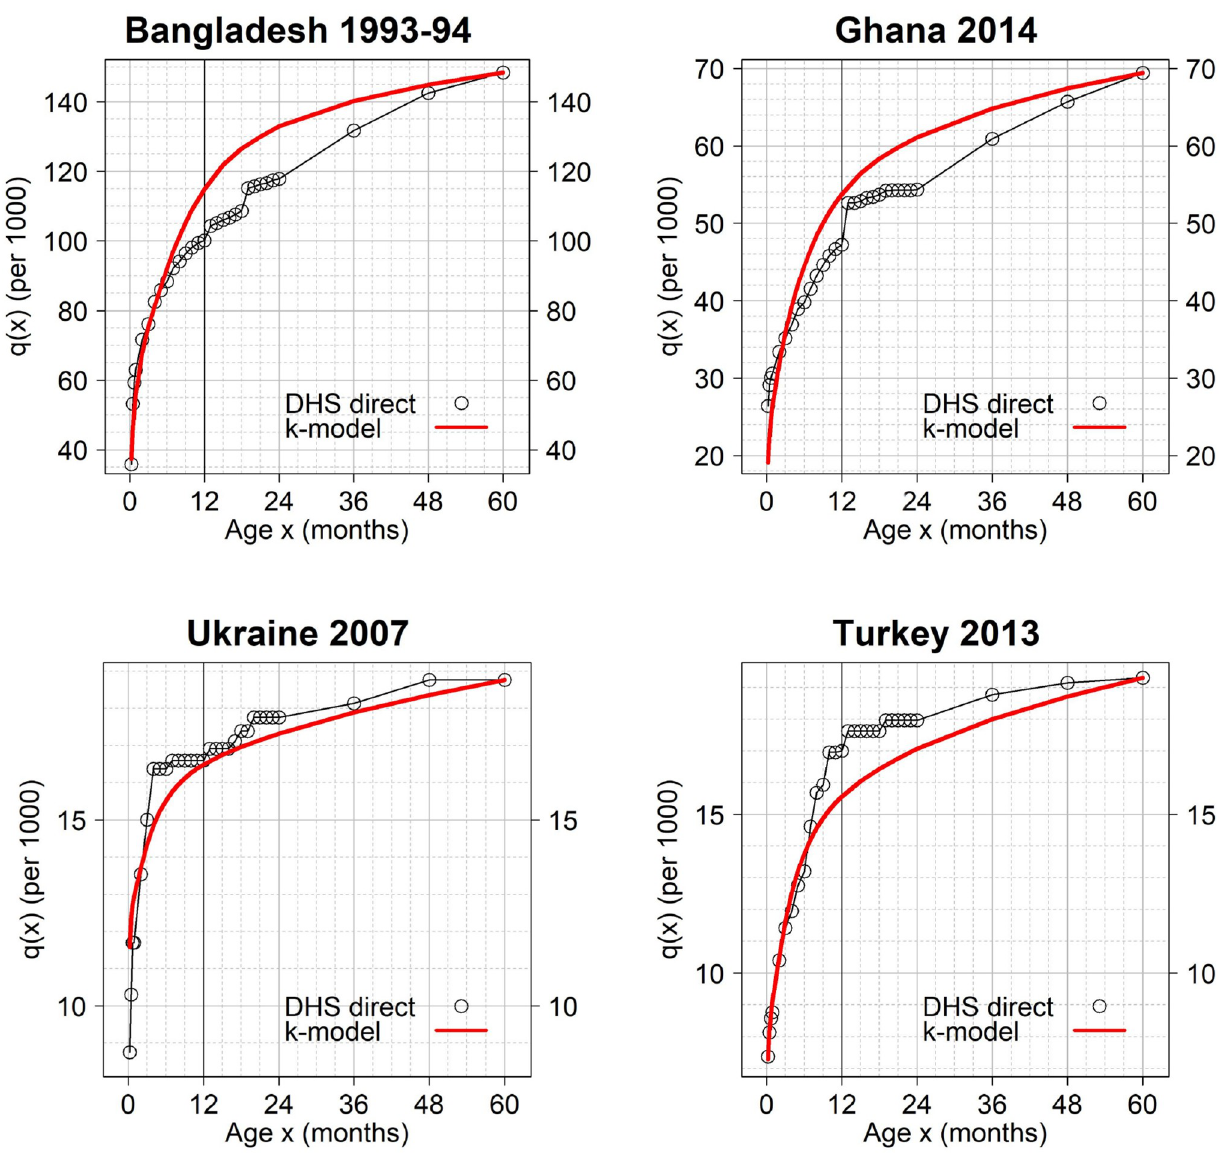
Fig 8. Examples of surveys excluded from analysis due to poor fit of the k-model. Prediction errors are outside the 99% maximum values. The k-model was fitted to the observed q ( x ) values using ages 0–8 and 24–60 months only. The ticker vertical line indicates the comparison between the observed and predicted infant mortality rate